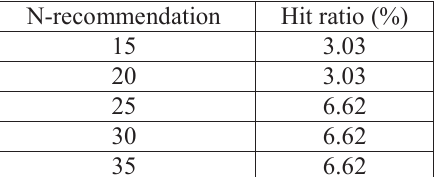
Table 2. N-recommendation vs Hit ratio